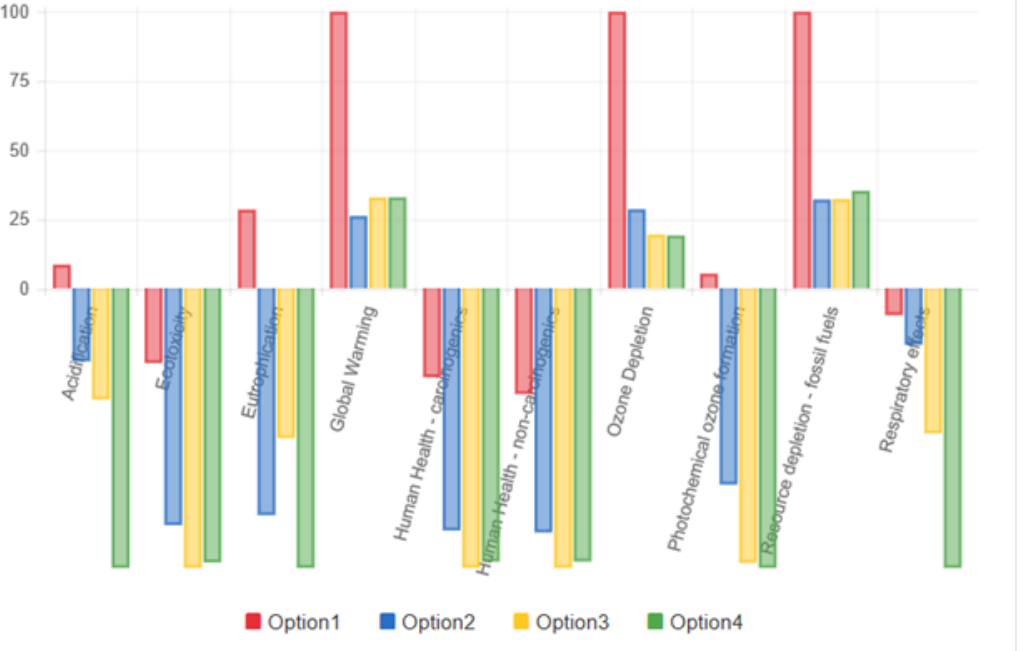
Figure 2 . Relative index of project